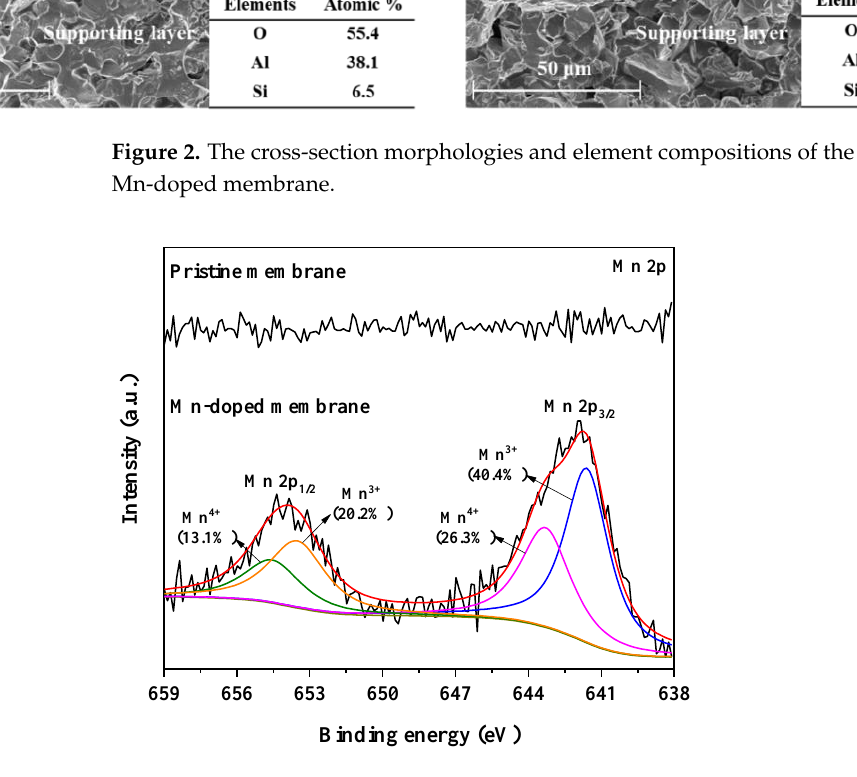
Figure 3. XPS spectra of Mn 2p of the pristine and Mn-doped membranes.